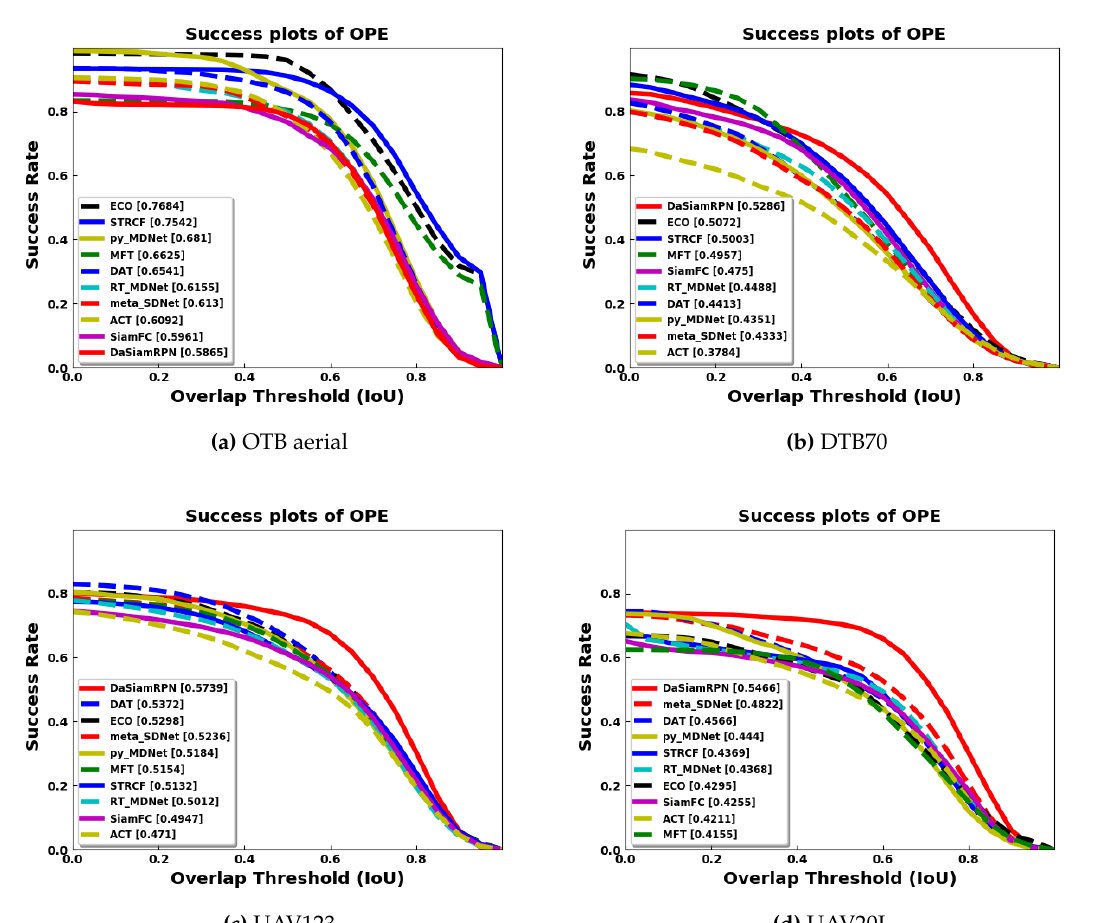
Figure 5. Overlap success plots of OPE for the aerial datasets. Results show that DaSiamRPN outperforms all other trackers in DTB70, UAV123, and UAV20L datasets. ECO performed well in the OTB aerial subset. Best viewed zoomed in and in